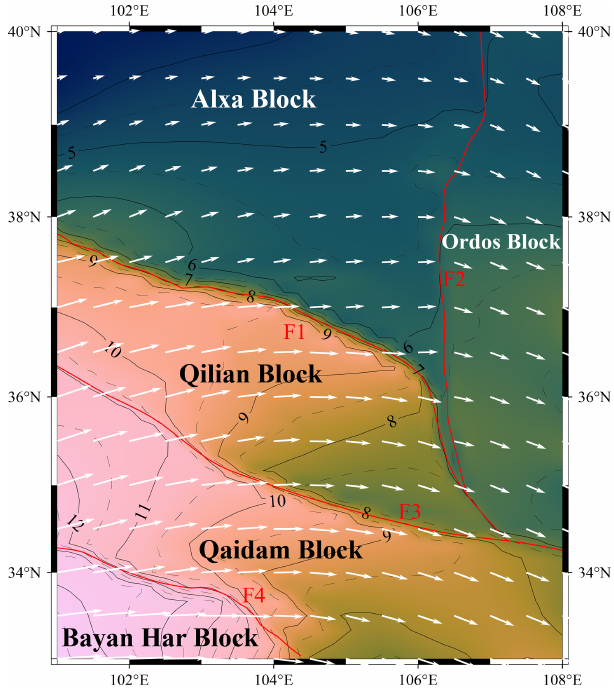
Figure 5. Distribution of modeled crustal surface velocities of the NETP with a grid interval of 0.5 ◦ in both longitude and latitude. White arrows represent the crust movement direction. The back- ground color contours represent the magnitude of the velocity (in mmyr − 1 ). The red lines represent the faults implemented in the model. The names are defined in Fig.